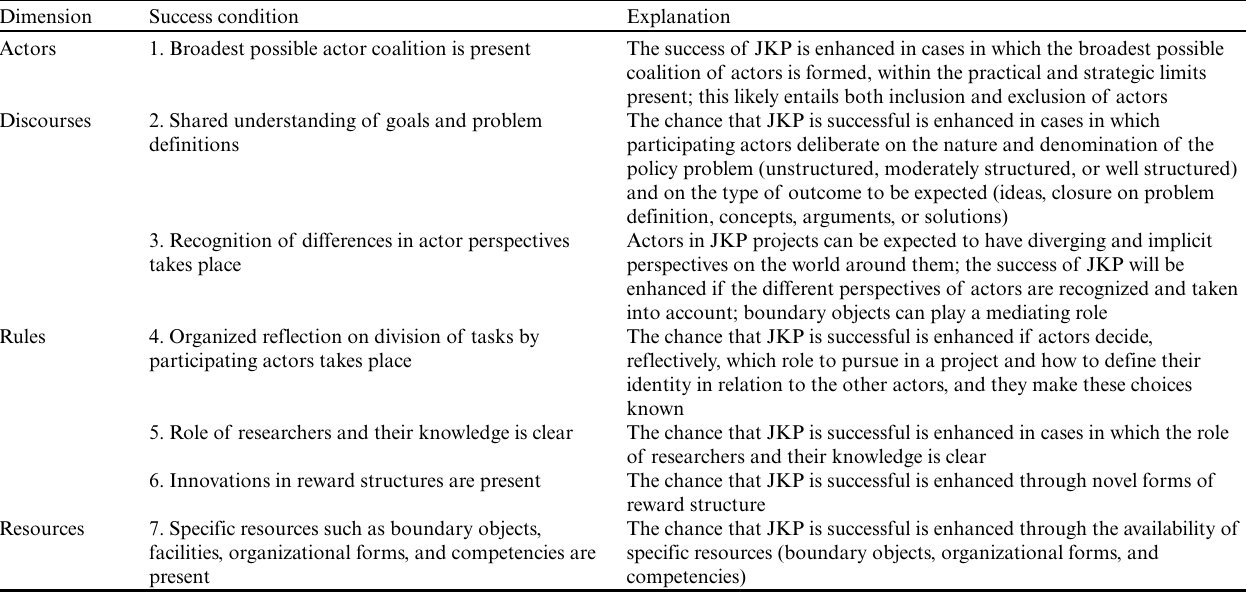
Table 1. Seven expected success conditions for joint knowledge production (JKP) projects. Adapted from Hegger et al. (2012 a: